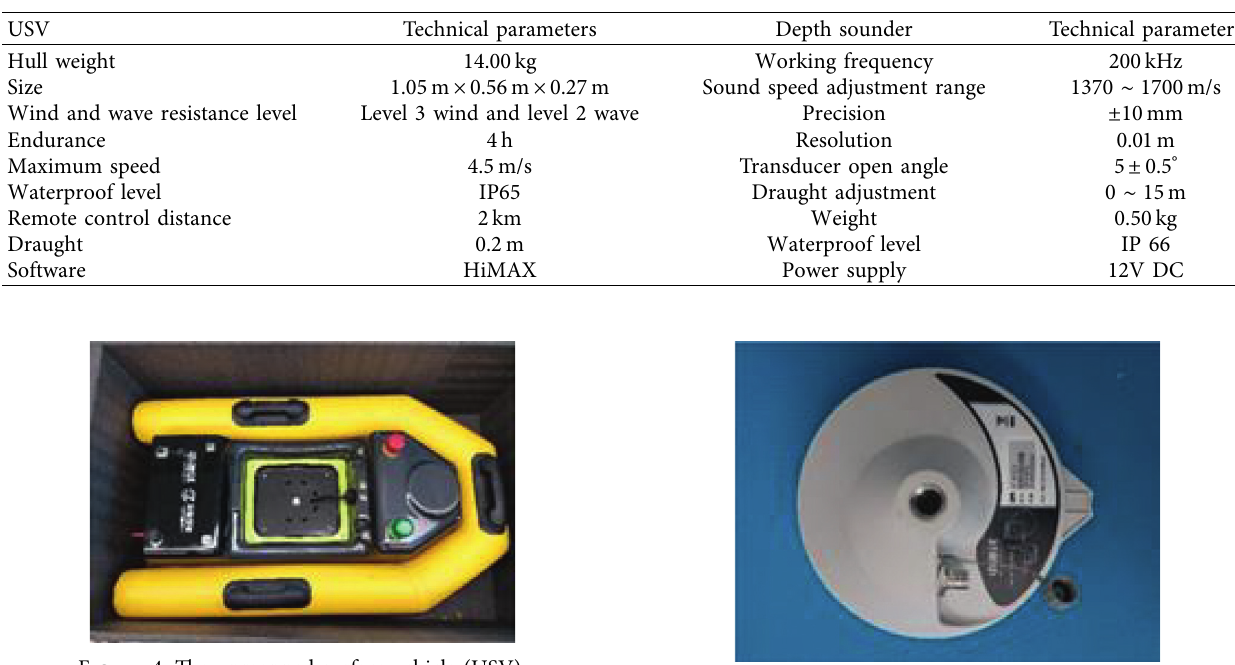
Figure 5: The real-time kinematic